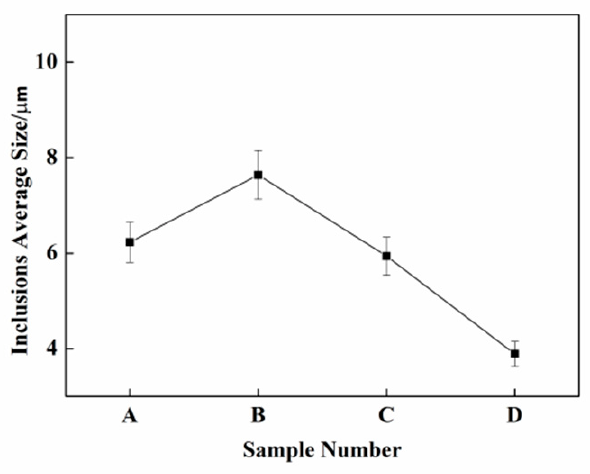
Figure 6. Average size distribution of inclusions in different TWIP steels.